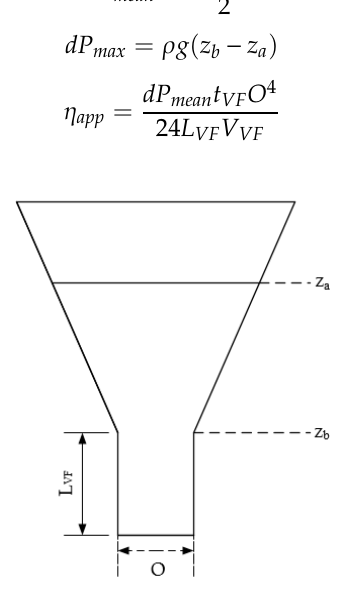
Figure 4. Schematic view of the V Funnel adapted from Mokéddem (2012) [47].